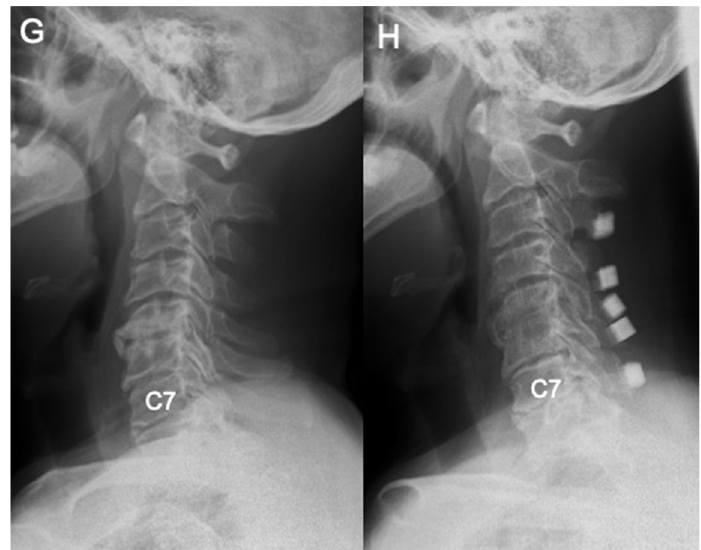
Figure 5. Pre and postoperative radiographs of patients with visible and invisible T1 slope. ( A , B ) Patient with invisible T1 slope: 50 years old, female, ossification of the posterior longitudinal ligament, C2-7 laminoplasty A; the preoperative radiograph, C2-7 SVA 39 mm, C2-7 angle 1°, C2 slope 27°, C7 slope 22°, B; the radiograph 1 year after surgery, C2-7 SVA 37 mm, C2-7 angle 11°, C2 slope 27°, C7 slope 17°. ( C , D ) Patient with invisible T1 slope: 51 years old, male, cervical spondylotic myelopathy, C3-7 laminoplasty A; the preoperative radiograph, C2-7 SVA 21 mm, C2-7 angle 15°, C2 slope 11°, C7 slope 22°, B; the radiograph 1 year after surgery, C2-7 SVA 18 mm, C2-7 angle 25°, C2 slope 5°, C7 slope 24. ( E , F ) Patient with visible T1 slope: 62 years old, female, ossification of the posterior longitudinal ligament, C5-7 laminoplasty A; the preoperative radiograph, C2-7 SVA 4 mm, C2-7 angle 7°, C2 slope 6°, C7 slope 7°, T1 slope 6°, B; the radiograph 1 year after surgery, C2-7 SVA 14 mm, C2-7 angle 2°, C2 slope 14°, C7 slope 16°, T1 slope 14°. ( G , H ) Patient with visible T1 slope: 44 years old, male, cervical spondylotic myelopathy, C3-7 laminoplasty A; the preoperative radiograph, C2-7 SVA 8 mm, C2-7 angle 12°, C2 slope 11°, C7 slope 17°, T1 slope 24°, B; the radiograph 1 year after surgery, C2-7 SVA 21 mm, C2-7 angle 1°, C2 slope 23°, C7 slope 18°, T1 slope 20°.